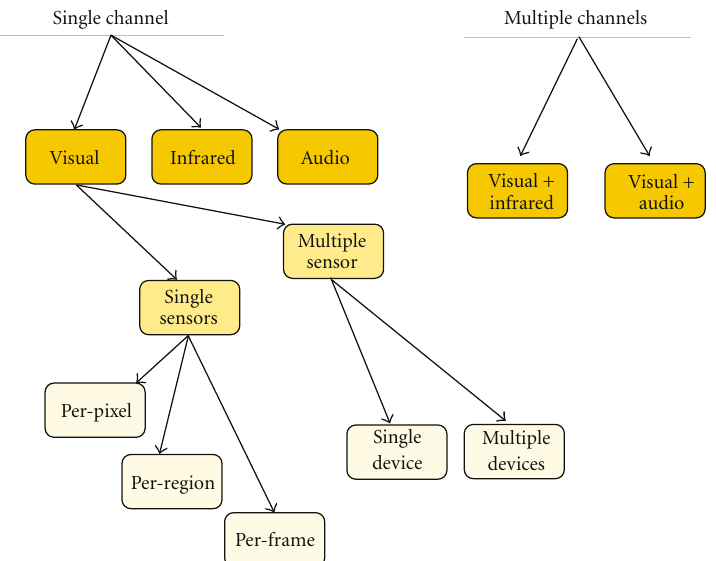
Figure 3: Taxonomy of the proposed background subtraction